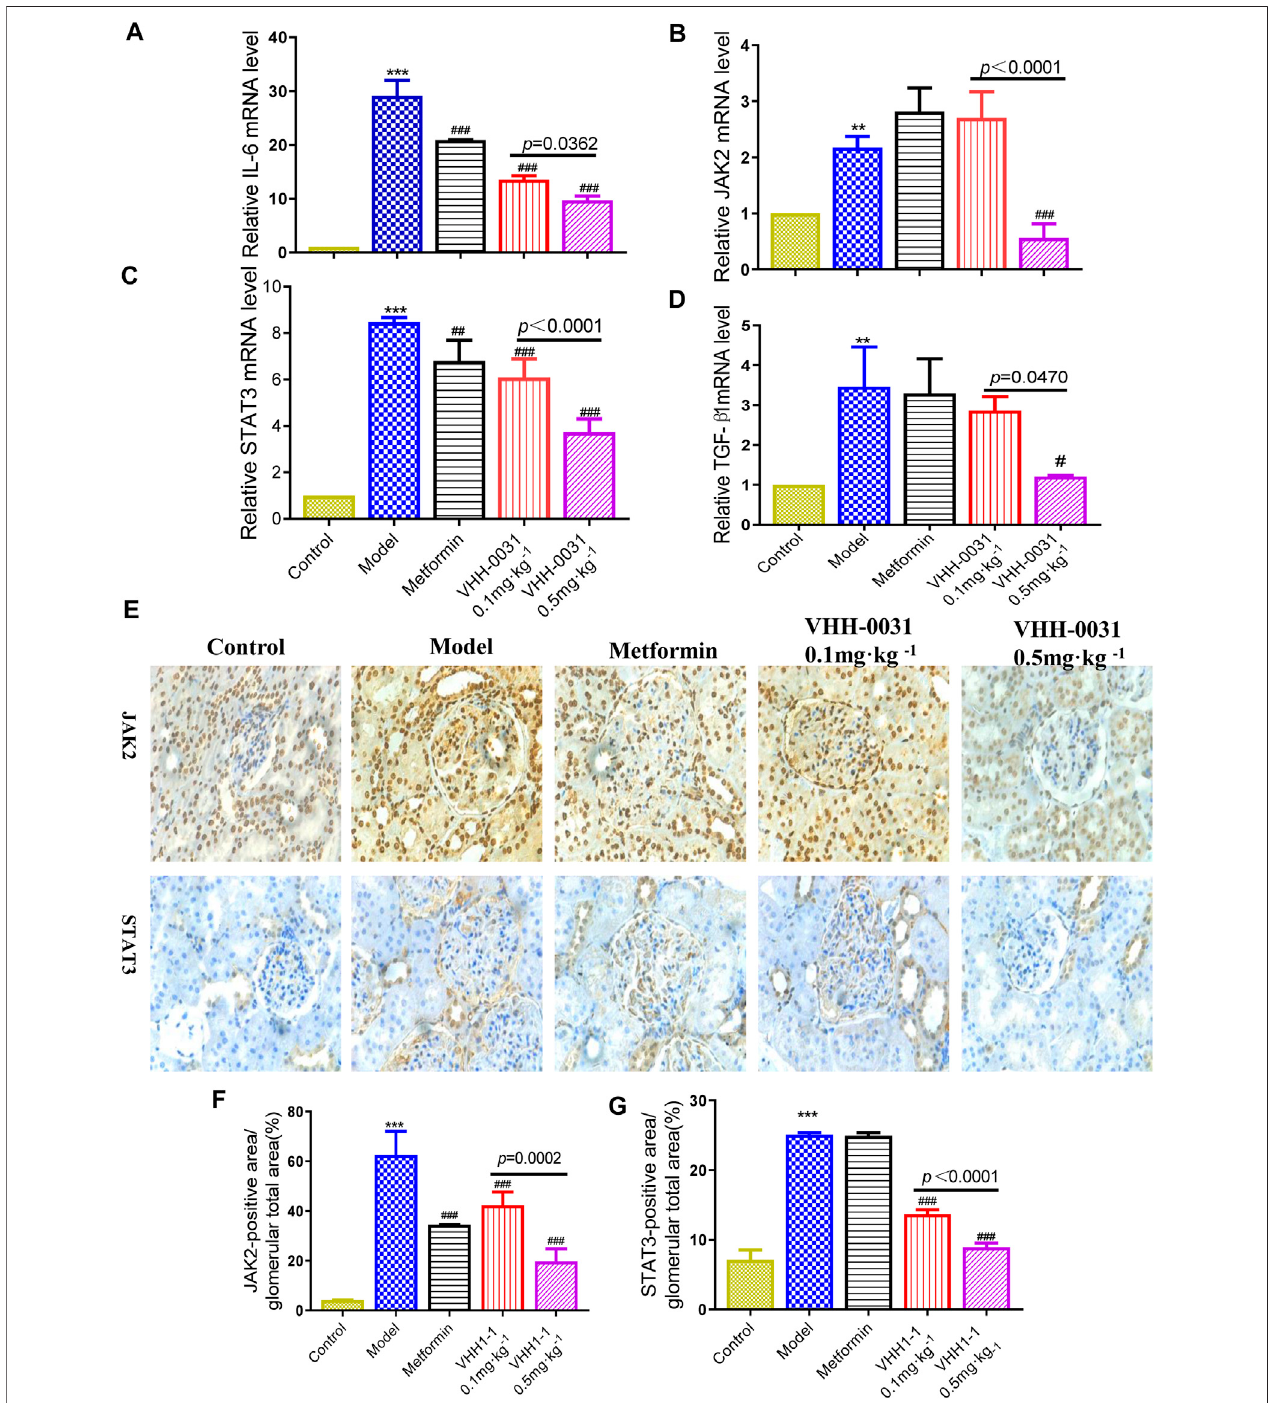
FIGURE 2 | Effect of VHH-0031 on JAK2-STAT3 signaling pathway in GK rats kidney. The mRNA expression of IL-6 (A) , JAK2 (B) , STAT3 (C) and TGF- β 1 (D) in kidneydetermined byqRT-PCR.Theexpression ofJAK2and STAT3 stainingmeasured byimmunohistochemistryinkidney (E) ,Bar (cid:1) 100 μ m( × 400). Quanti fi cationof JAK2 (F) andSTAT3 (G) proteinmeasuredbyimmunohistochemicalstaining.Datarepresentsthemean ± SDforsixratspergroup.Control:Wistarrats,Model:GKrats, Metformin: GK ratstreatedwith metformin 500 mg kg − 1 ,VHH-0031 0.1 and 0.5 mg kg − 1 :GK ratstreated withthe recombinantanti-IL-6Rfusion proteins (0.1 and 0.5 mg kg − 1 ). * p < 0.05, ** p < 0.01, *** p < 0.001 vs control group. # p < 0.05, ## p < 0.01, ### p < 0.001 vs model